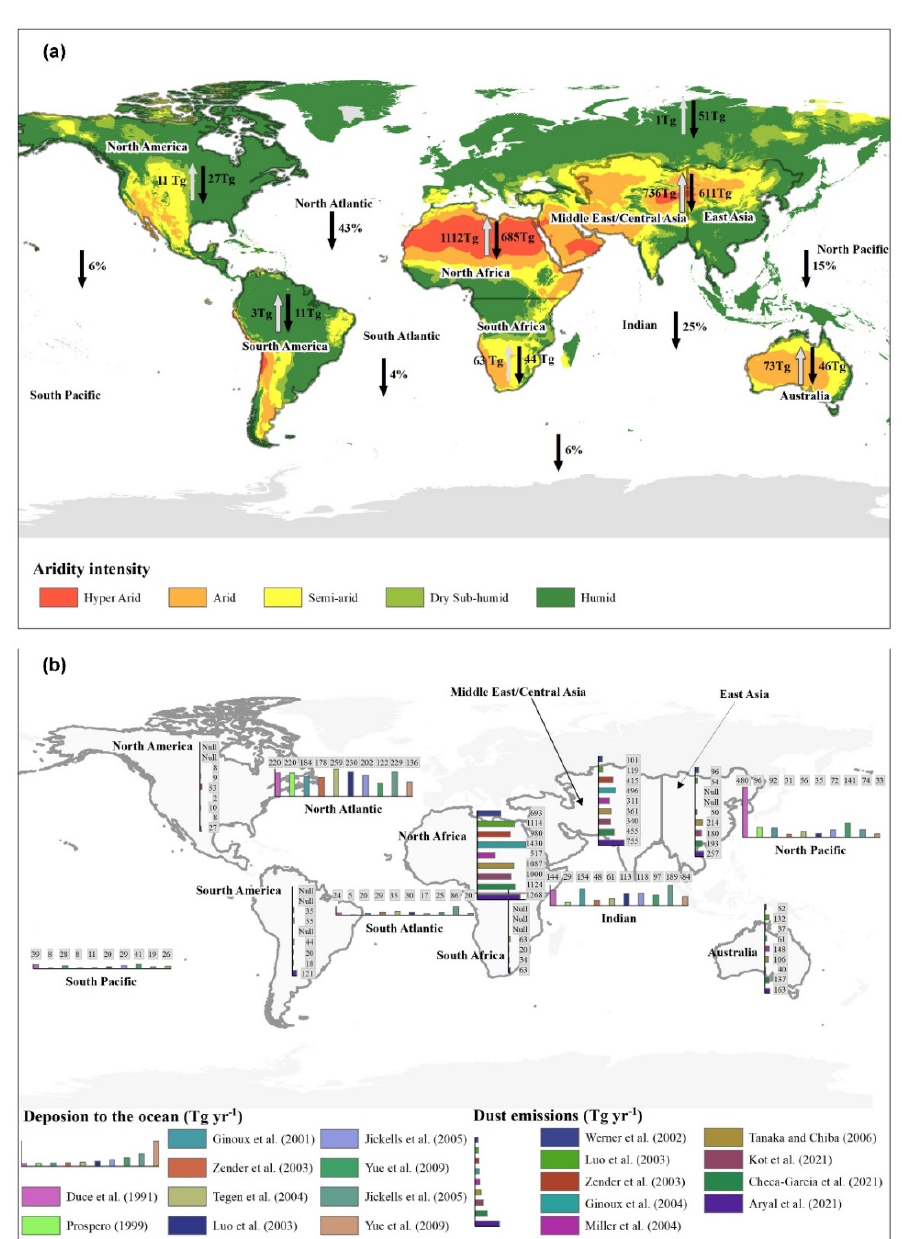
Figure 3. Map of global ( a ) dust emissions, deposition, and ( b ) dust budgets at different regions, estimated by several dust models. Grey and black arrows in ( a ) denote dust emission and deposition (percent of the total dust deposition worldwide), respectively. Horizontal and vertical bars in ( b ) denote annual dust emission (from land regions) and deposition (in oceans), respectively, estimated by different studies. The particle size ranges (r) of dust emissions are Werner et al. [109], 0.1 ≤ r ≤ 219 µ m; Luo et al. [108], 0.1 ≤ r ≤ 10 μ m; Zender et al. [42], 0.1 ≤ r ≤ 10 μ m; Ginoux et al. [33], 0.1 ≤ r ≤ 6 µ m; Miller et al. [110], r < 10 μ m; Tanaka and Chiba [55], 0.2 ≤ r ≤ 20 µ m; Kok et al. [80], 0.2 ≤ r ≤ 20 µ m; Checa-Garcia et al. [117] and Aryal et al. [116], multi-model with different maximum dust particle size.